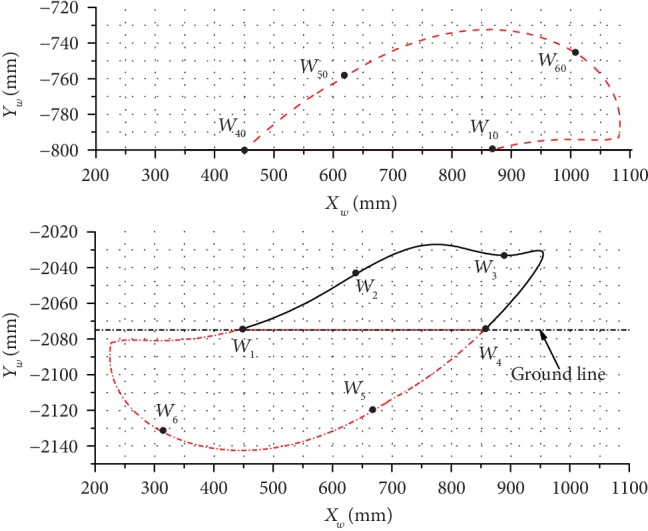
The trajectories of the leg end-point (bottom) and the body (top) at α1 = 12.5°.